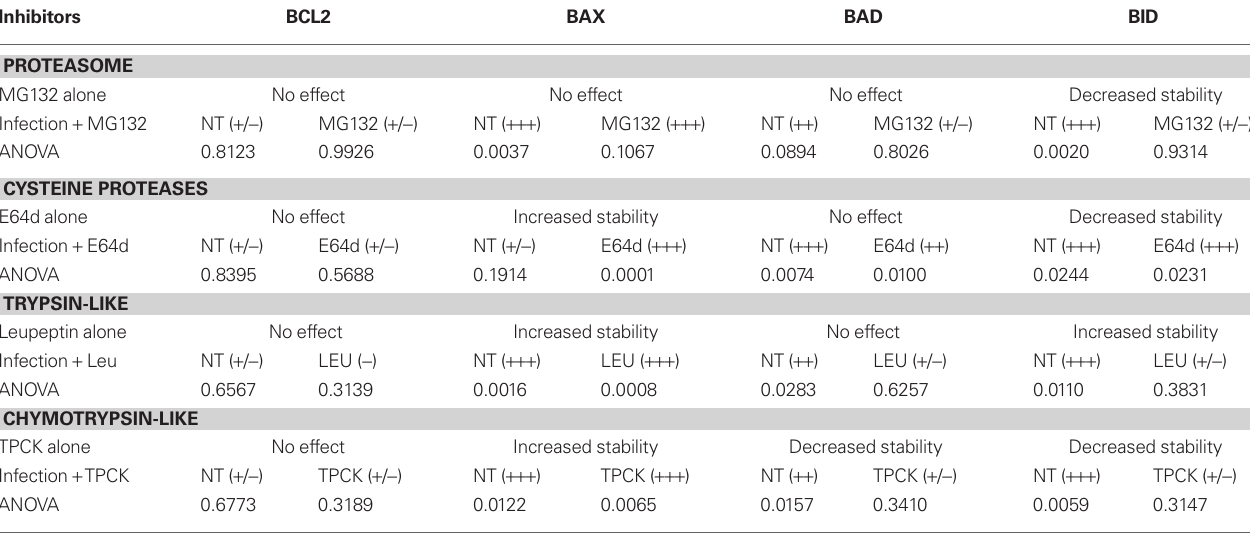
Table 1 | impact of proteasome and protease inhibition on the stability of BCL2-family proteins in uninfected cells and in response to infection. inhibitors